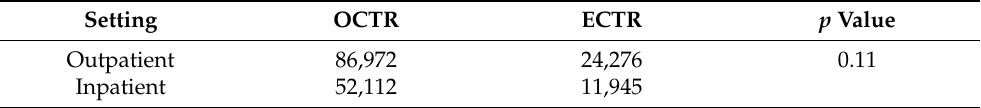
Table 1. Comparison of outpatient and inpatient surgery by surgical procedure, 2015–2019 (5